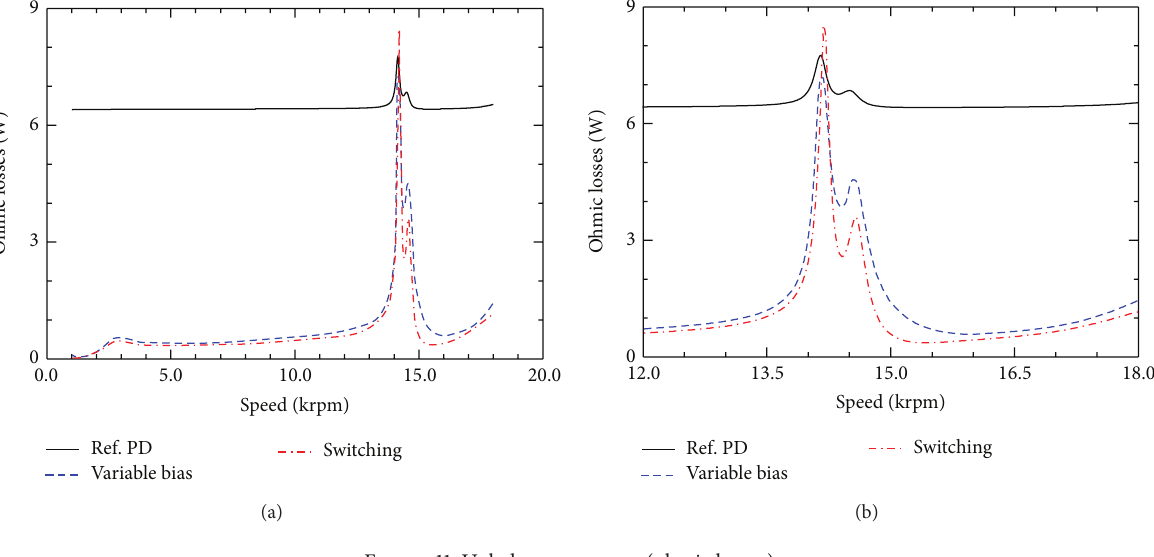
Figure 11: Unbalance response (ohmic